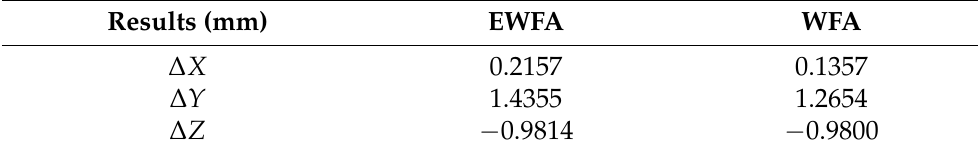
Table 13. Error comparison of the first experiment.